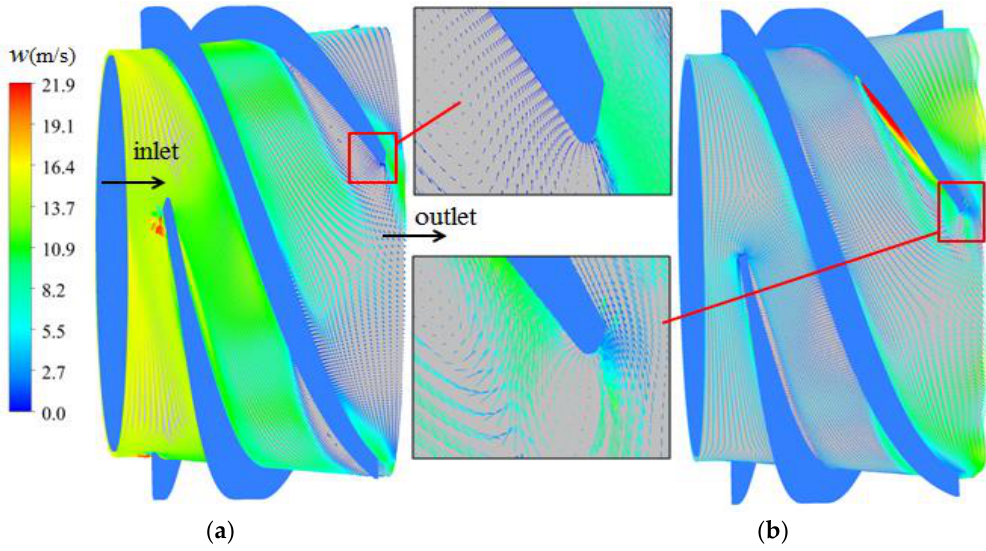
Figure 7. Distribution of superficial velocity in the impeller at IGVF = 21%. ( a ) Liquid superficial velocity; ( b ) Gas superficial velocity.